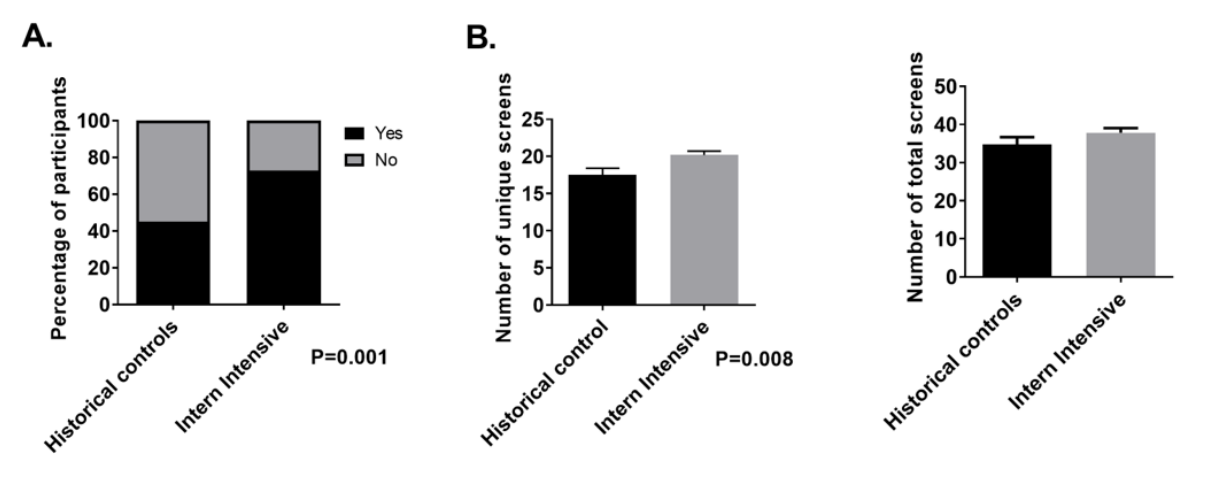
Figure 3. Parameters of screen use. Reference residents (n=62, 100%) and intervention interns with available data (n=70, 99%) had data gathering navigation patterns during postlesson simulation recorded. Panel A: number of reference residents and intervention interns who used the most common 10 screens among all participants. Intervention interns used these most common screens more frequently than participants using previously established workflow (73% vs 45%; P =.001). Panel B: number of total screens and unique screens visualized by reference residents and intervention interns. Although there was no difference in total screens used between groups, intervention interns used more unique screens than the reference (20.2 vs 17.5; P =.008).